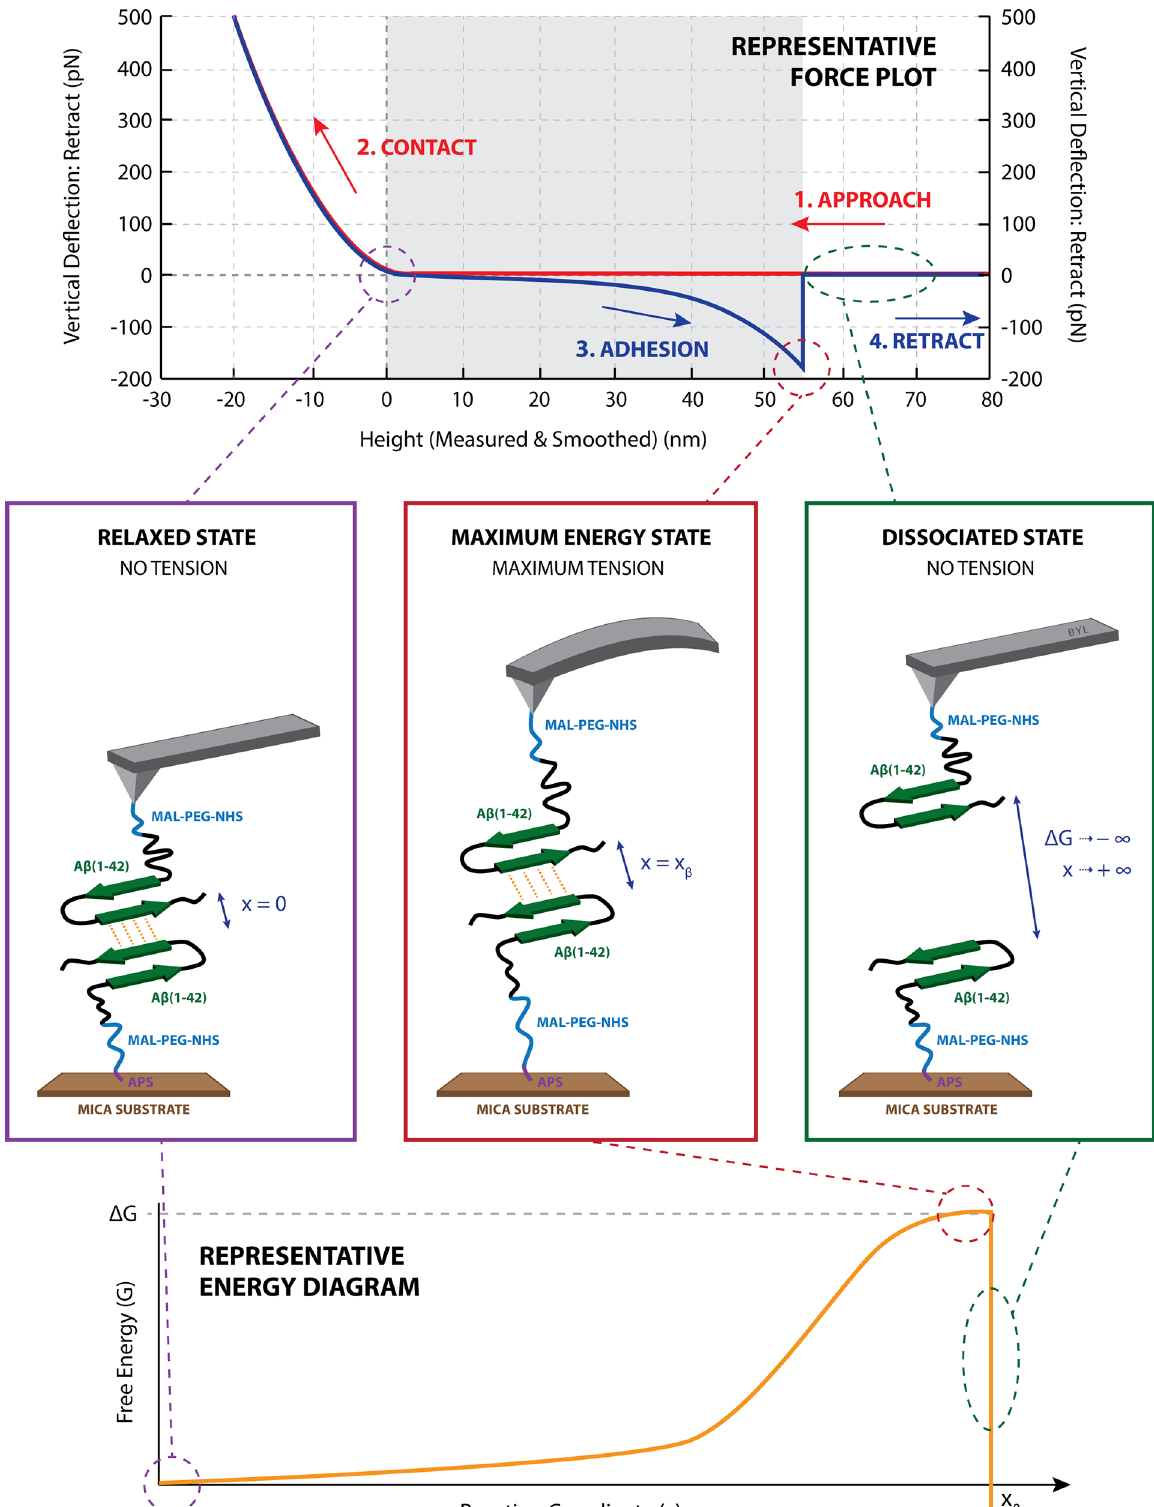
Fig 1. Mechanically induced A β binding and dissociation. (A) is a representative experimental force plot: the tip approaches the sample (red line) and when it touches the surface — the cantilever bends (steep linear region). The two surface-bound monomers are allowed to bind (red to blue transition at top of